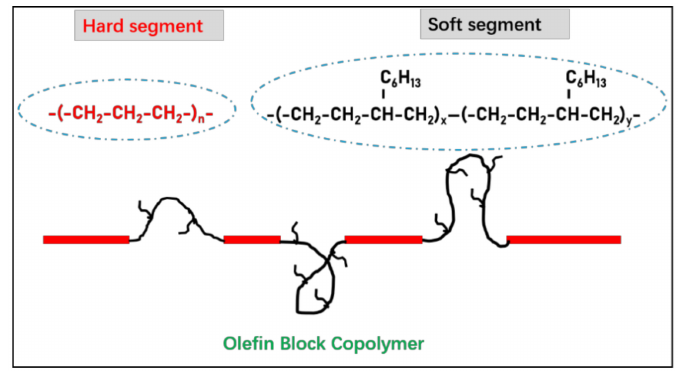
Scheme 1. Chain architecture and chemical structure of olefin block copolymer